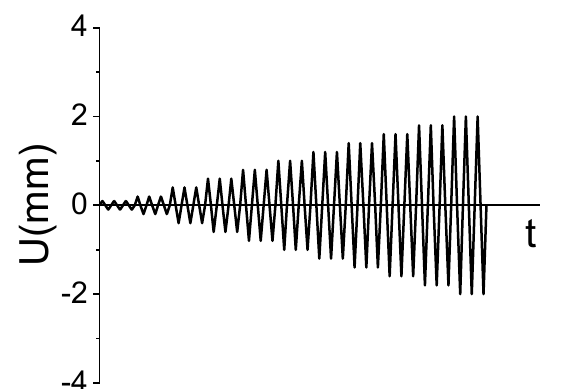
Figure 4. Loading device.